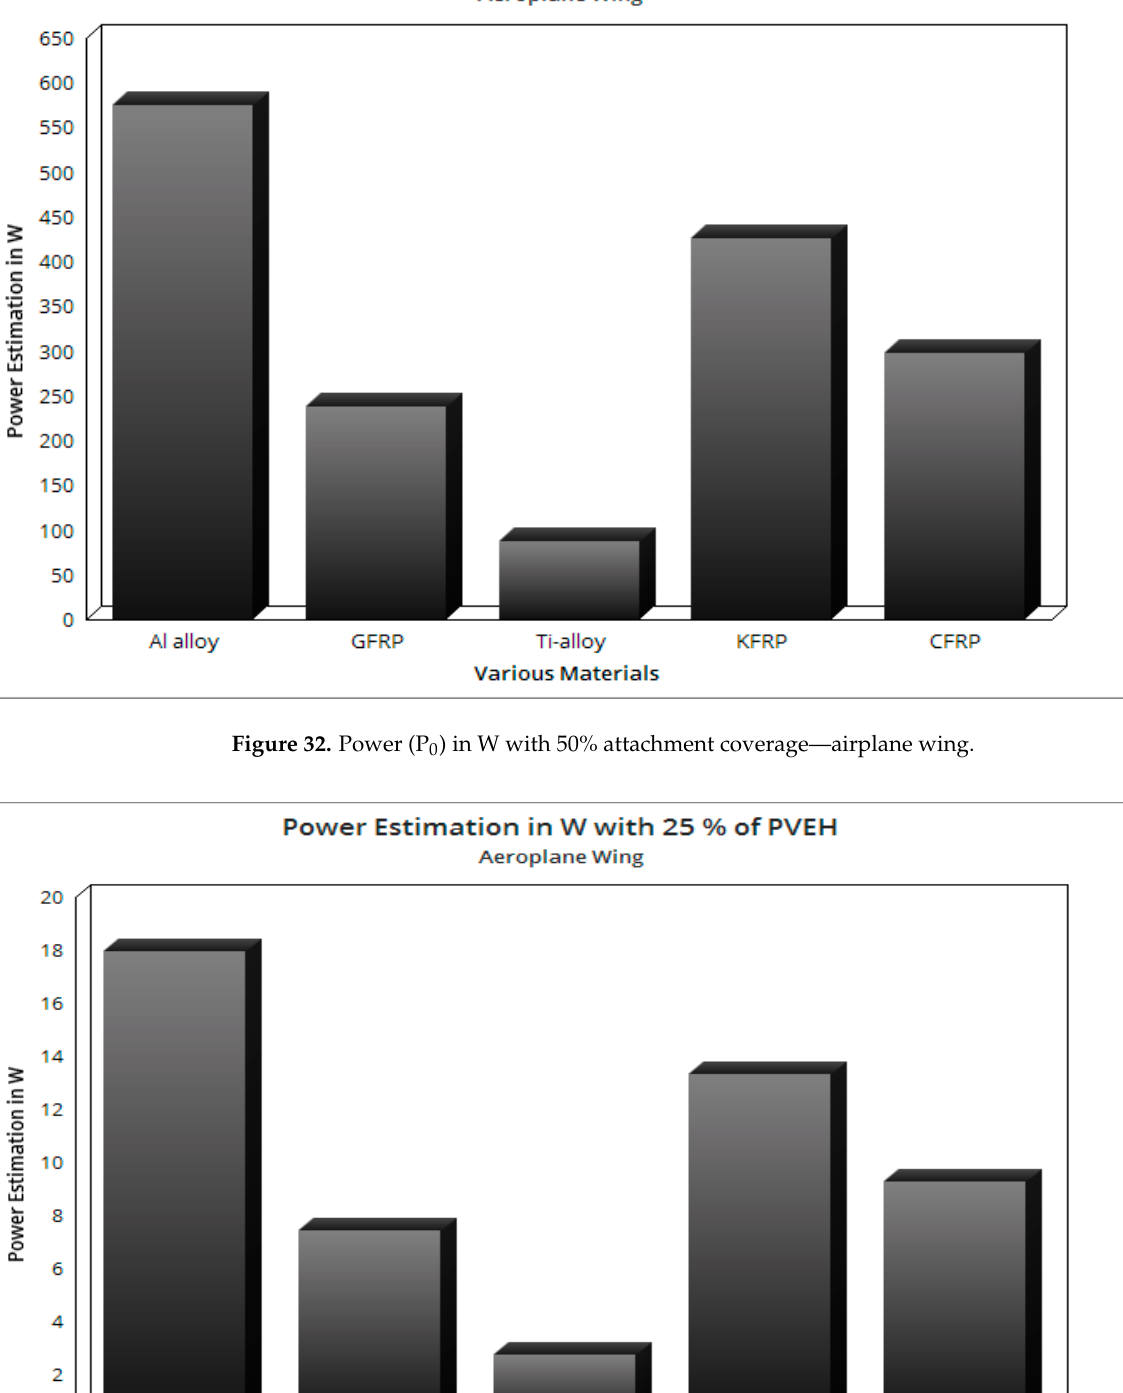
Figure 31. Power (P 0 ) in W with 75% attachment coverage—airplane wing.